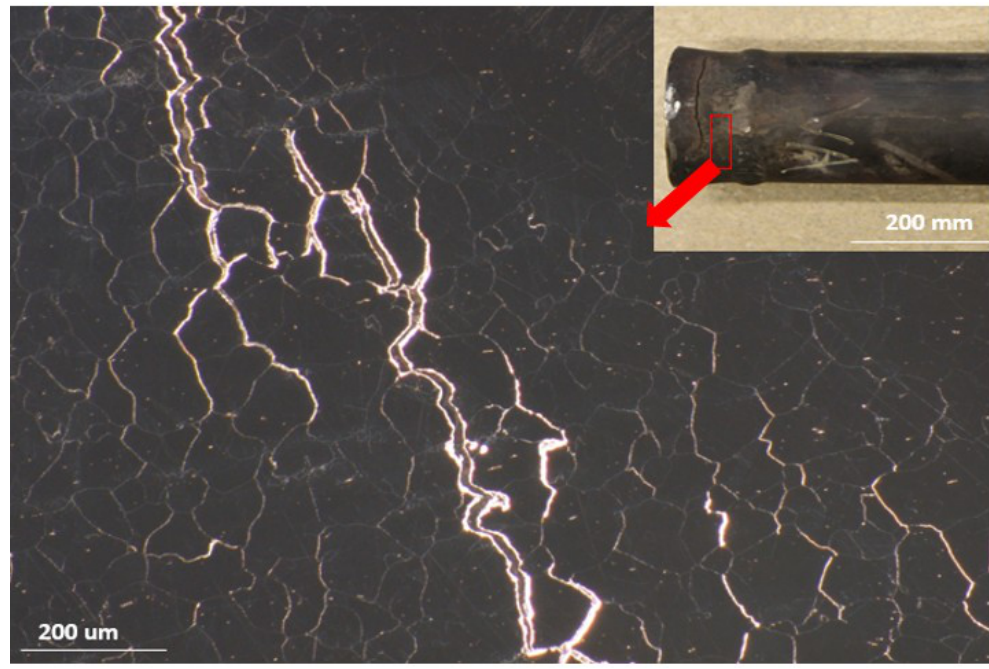
Figure 1. Macro and stereomicroscopic images of failed specimen.